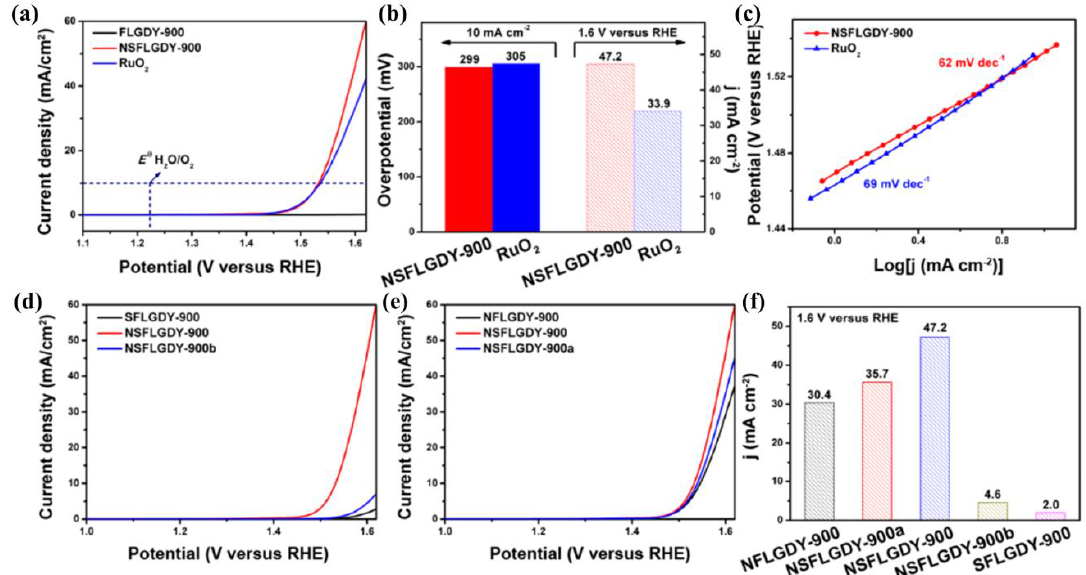
Figure 18. OER electrochemical characterizations of polyatomic co-doped GDY. ( a ) Polarization curves of FLGDY-900, NSFLGDY-900 and RuO 2 catalysts; ( b ) corresponding overpotential and current density of NSFLGDY-900 and RuO 2 catalysts; ( c ) Tafel plots of NSFLGDY-900 and RuO 2 catalysts; ( d ) polarization curves of SFLGDY-900, NSFLGDY-900 and NSFLGDY-900b catalysts; ( e ) polarization curves of NFLGDY-900, NSFLGDY-900 and NSFLGDY-900a catalysts; ( f ) current density of catalysts at 1.6 V (vs. RHE) (reproduced with permission from [78]. Copyright American Chemical Society, 2019).